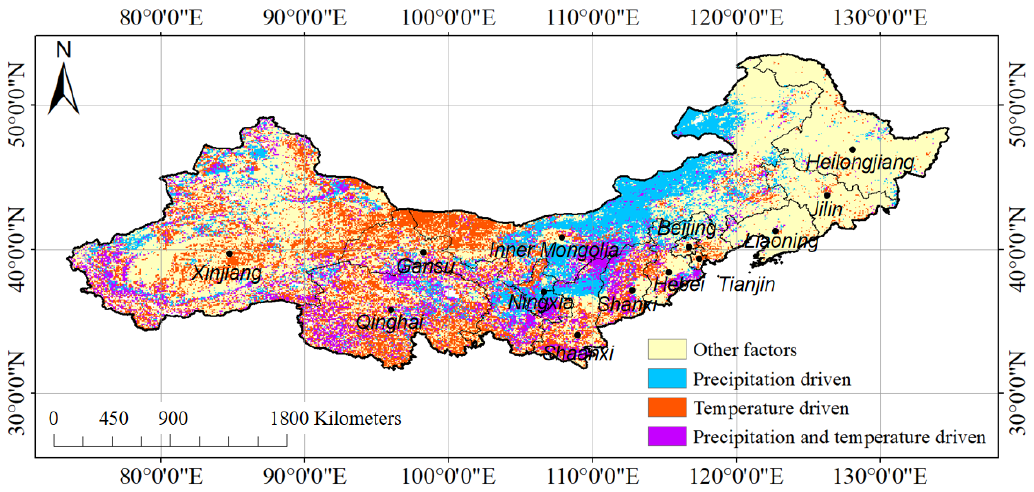
Figure 5. Distribution of the four NDVI driver types for northern